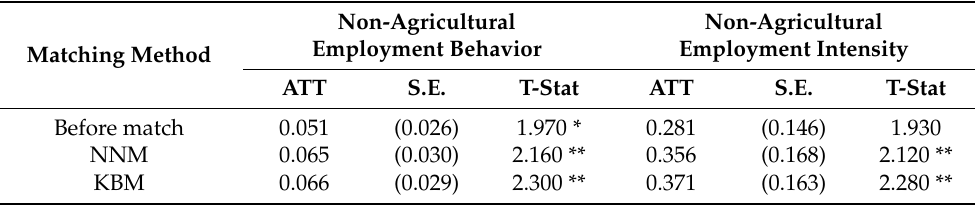
Table 3. Robustness test by PSM